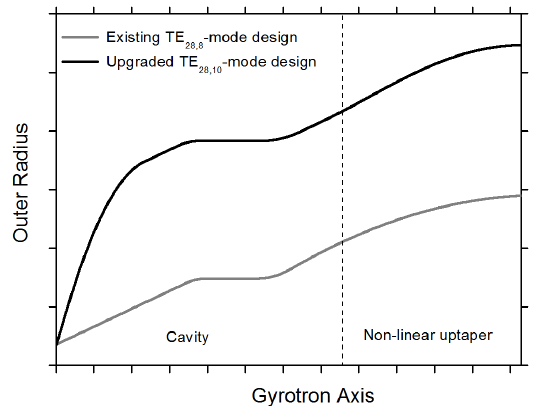
Fig. 1. Schematic of the cavity and non-linear uptaper of the existing W7-X gyrotron and of the upgraded W7-X gyrotron . The performance of the non-linear uptaper, in terms of mode conversion, has been validated numerically. The